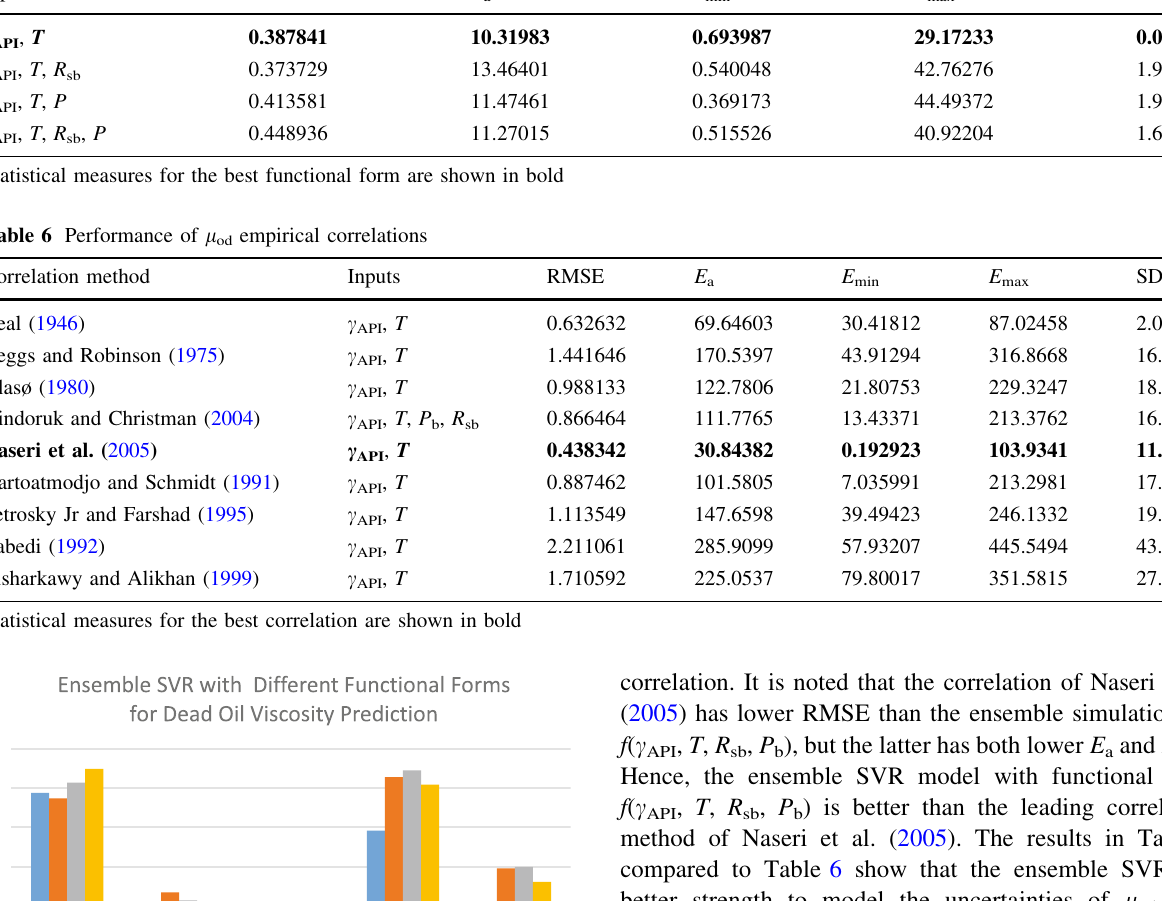
Table 5 Performance of the ensemble SVR for the functional forms for l od Inputs